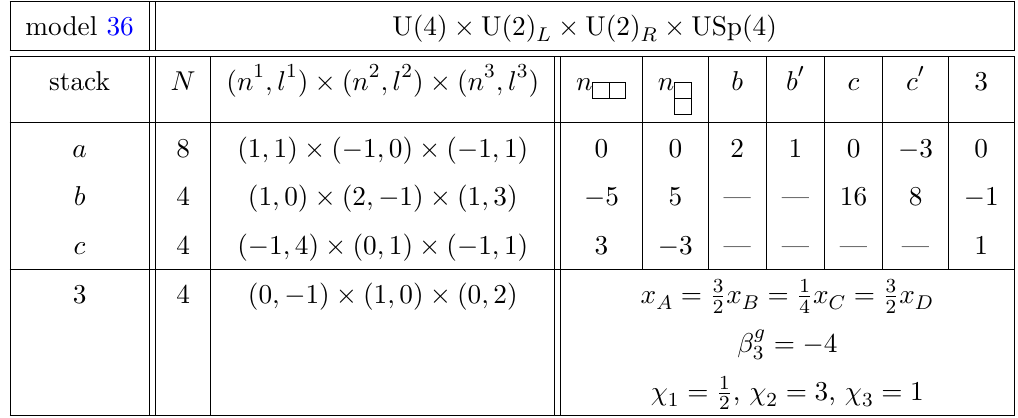
Table 36 . D6-brane configurations and intersection numbers of Model 36, and its MSSM gauge